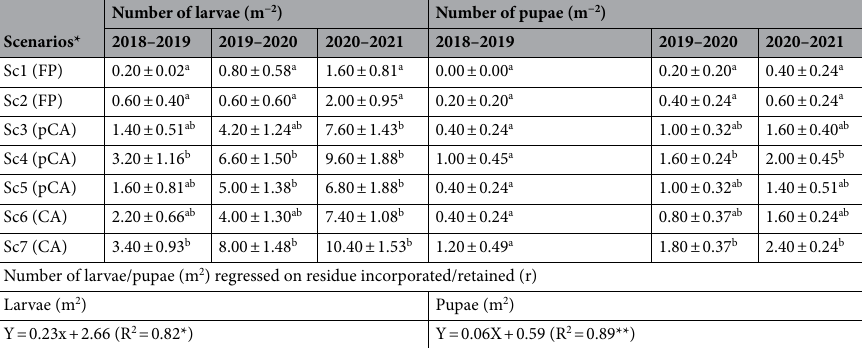
Table 1. Infestation of Mythimna separata (mean numbers of larvae & pupae) on wheat crop and their correlations with incorporated/retained residue in different tillage-cum-crop establishment and residues management practices of Indo-Gangetic Plains at 65 days after sowing (larvae) and after harvesting of crop (pupae) during recent different years. Mean values followed by standard error and different superscript small letters within a column are significantly different; * and ** indicate significant at P <0.05 and <0.001, respectively.